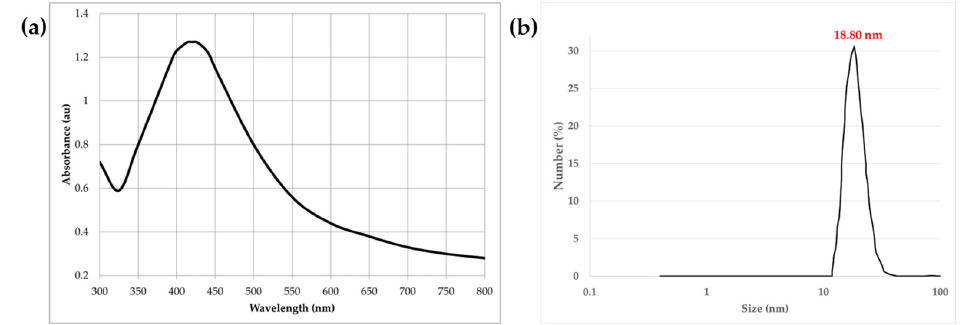
Figure 5. Physical characterization of AgPP NPs: ( a ) UV/Vis spectra for AgPP NPs with peak maxima at 400 nm with a broad shoulder stretching to near 700 nm (left) and ( b ) size distribution curve.